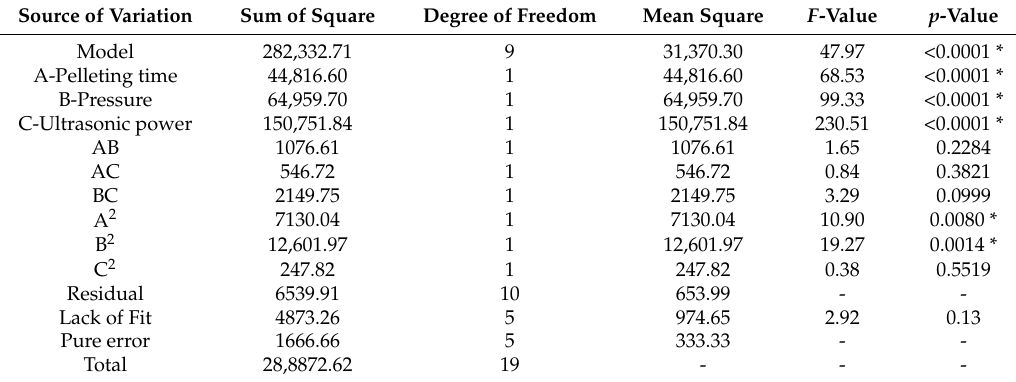
Table 2. The analysis of variance (ANOVA) results of the pellet density in a full model.